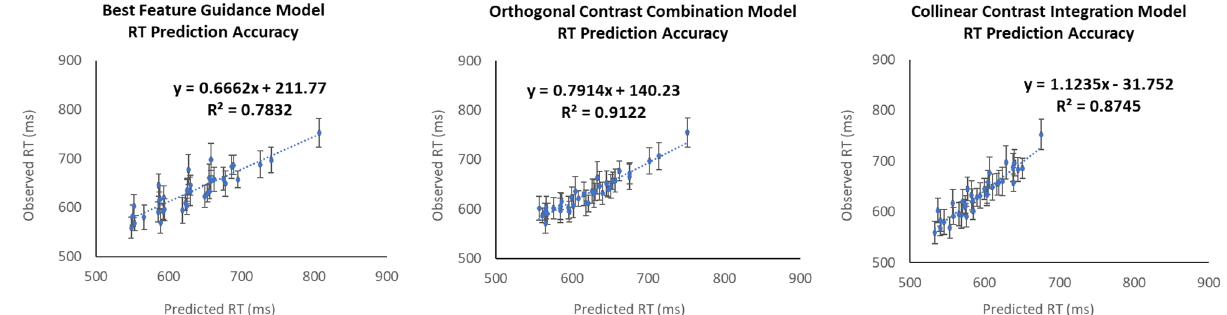
Figure 6. Reaction time prediction accuracy of Eqs. (6)–(8) according to the Best Feature Guidance Model (left panel), the Orthogonal Contrast Combination Model (middle panel), and the Collinear Contrast Integration Model (right panel), respectively, based on the unfinished confirmatory study. Error bars on each data point indicate the standard error of the observed reaction time for each specific condition. Once again, the Orthogonal Combination Model outperformed the other two